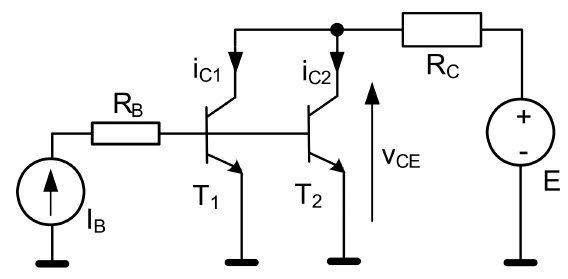
Figure 11. Two connected parallel BJTs.